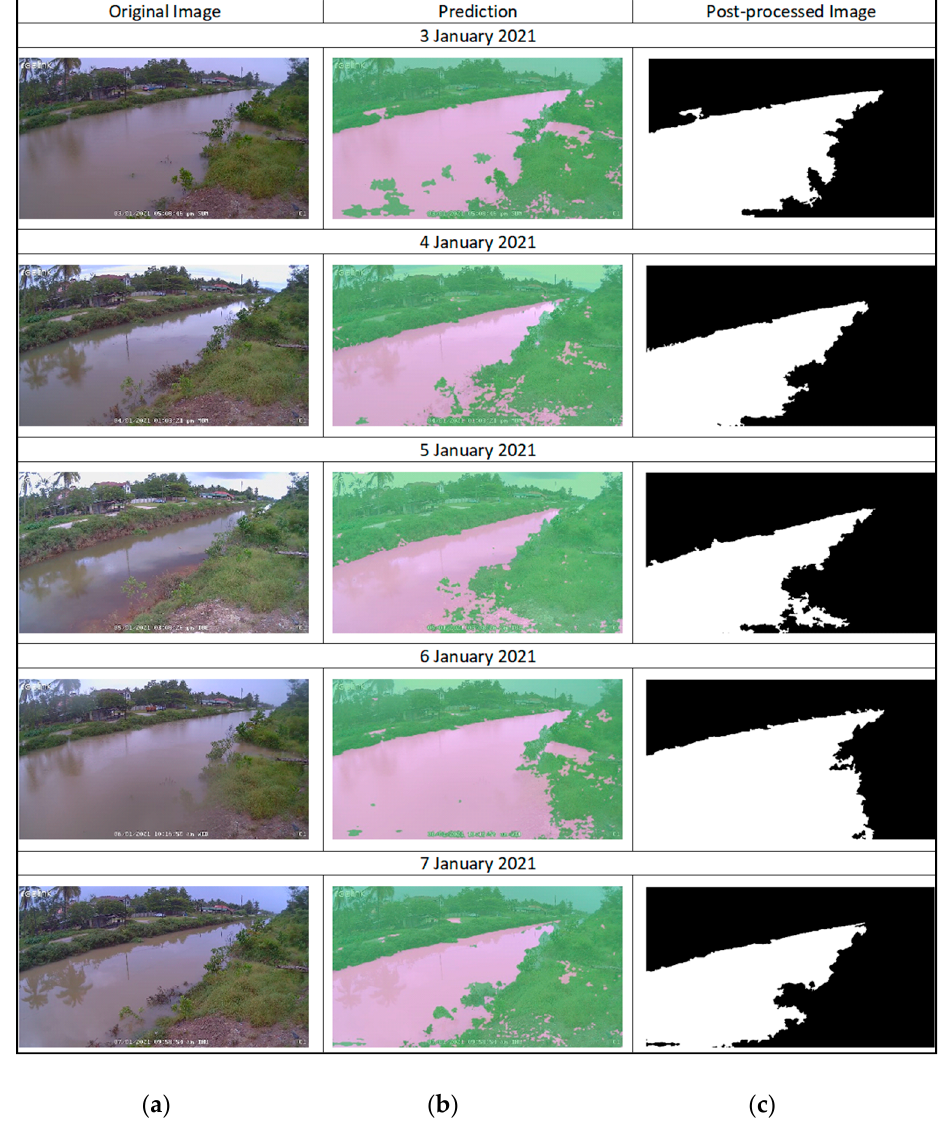
Figure 14. ( a ) The original images were captured on different days ( b ) The segmentation results obtained when using DeepLabv3+ model ( c ) Results after performing morphological operations.